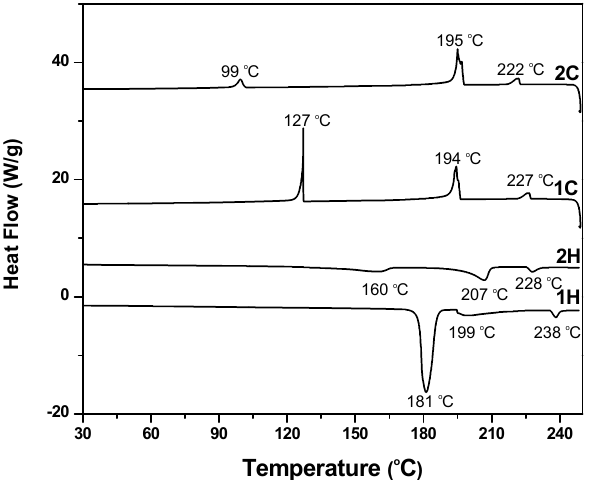
Figure 3. DSC thermograms of V6 obtained at heating and cooling rates of 10 °C/min in nitrogen.